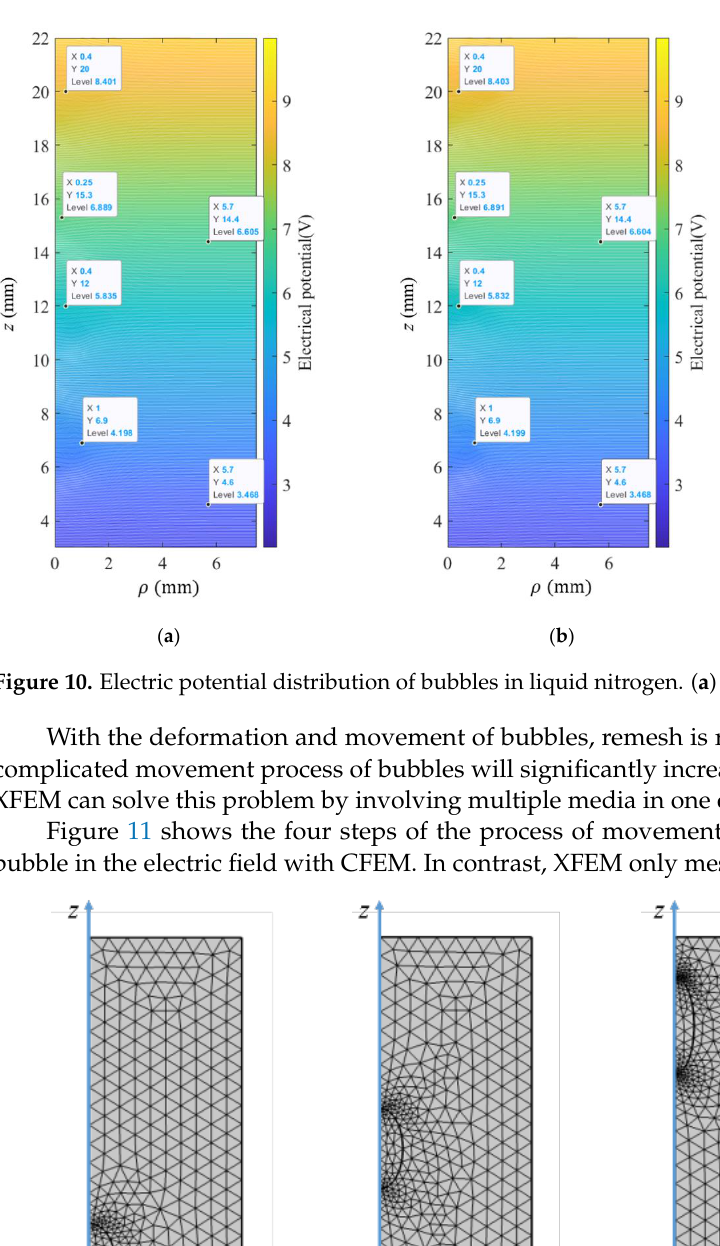
Figure 9. Meshing of the bubbles in liquid nitrogen. ( a ) CFEM, ( b ) XFEM